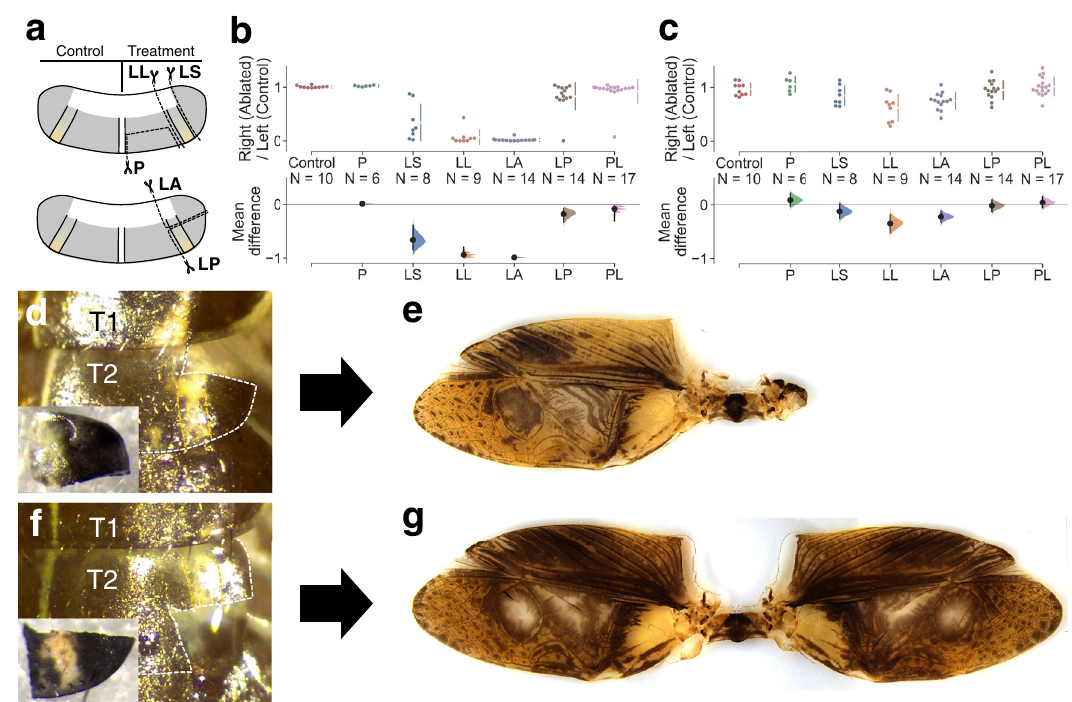
Fig. 3 Identi fi cation of wing growth organizer in the lateral-anterior region of thoracic terga. a Schematic illustration indicates ablated regions in the third instar nymph: P posterior, LS lateral-small, LL lateral-large, LA lateral-anterior, LP lateral-posterior. Effect of nymphal tergal ablations on wing ( b ) and articulation ( c ) sizes in adults. PL pleuron. Cumming plots indicate relative area of the treated right side to untreated left side (top) and mean differences of the values from control for wing ( b ) and articulation ( c ) regions (bottom). Source data are provided as a Source Data fi le. d – g Representative results of the ablation treatment. The right side of targa of the third instar nymph after the ablation of the LA ( d ) and LP ( e ) regions. The ablated tissues are shown in insets. Resultant adult wings of the same individuals are shown in f and g , respectively. Mesoterga and the yellowish line is outlined with white and yellow dotted lines,